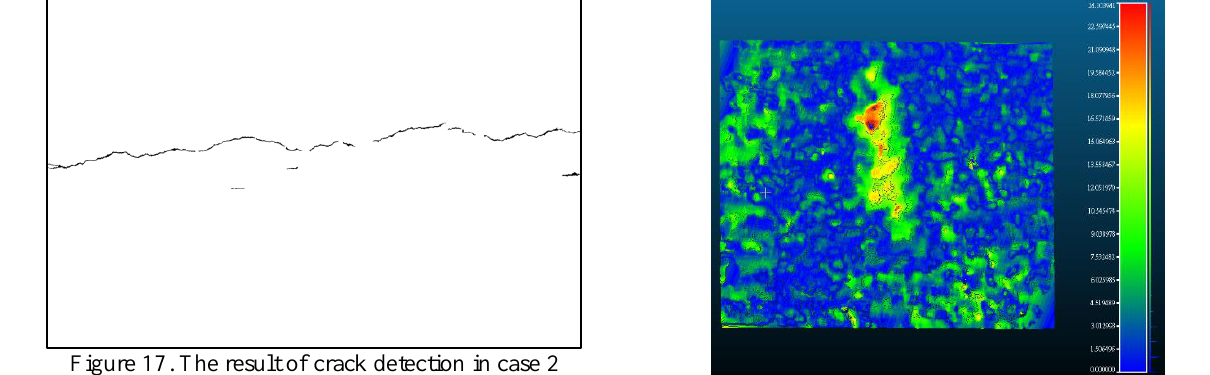
Figure 20. The elevation model presented by false